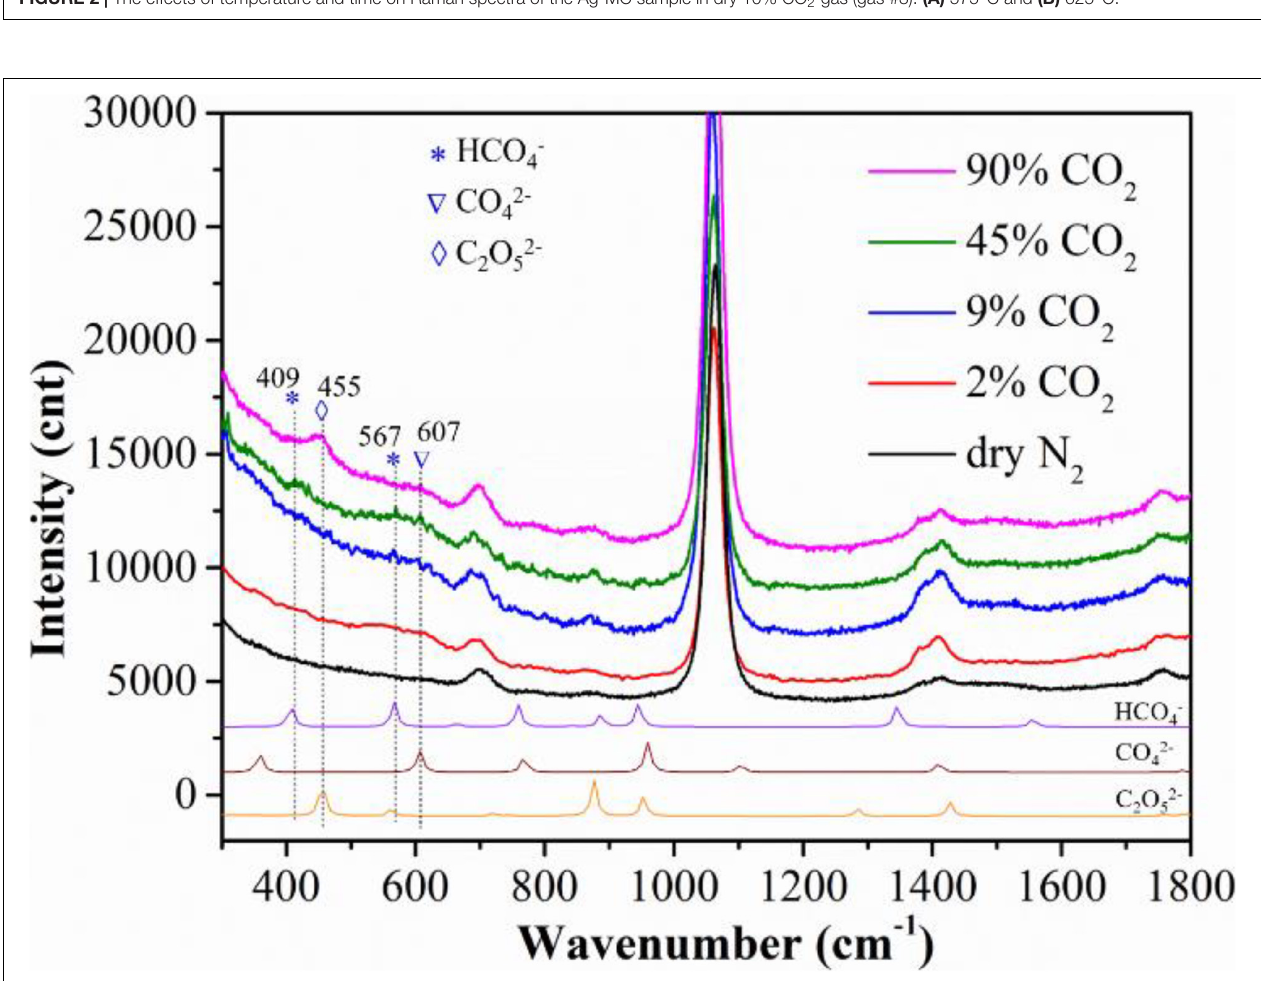
FIGURE 3 | Raman spectra, along with DFT calculations, of the Ag-MC sample collected at 625 ◦ C in different CO 2 concentration gas conditions: dry N 2 (gas #1), 2% CO 2 (gas #4), 9% CO 2 (gas #5), 45% CO 2 (gas #6), 90% CO 2 (gas #7).